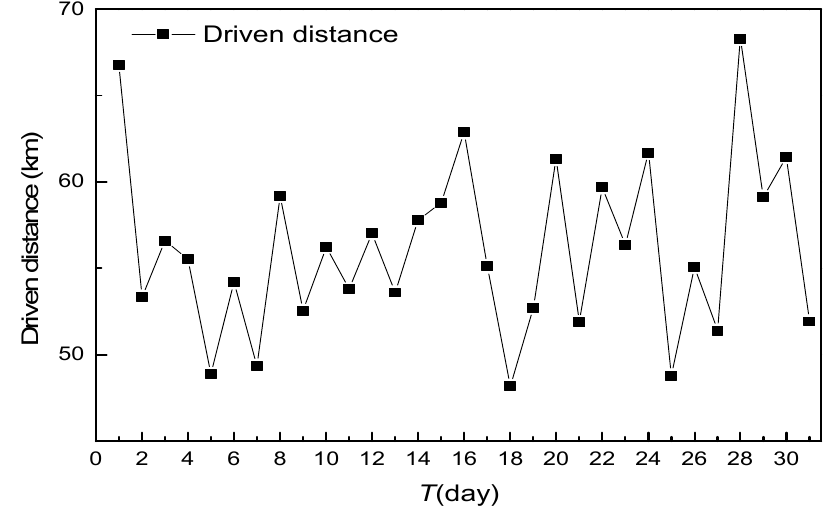
Figure 11. Electric vehicle mileage.